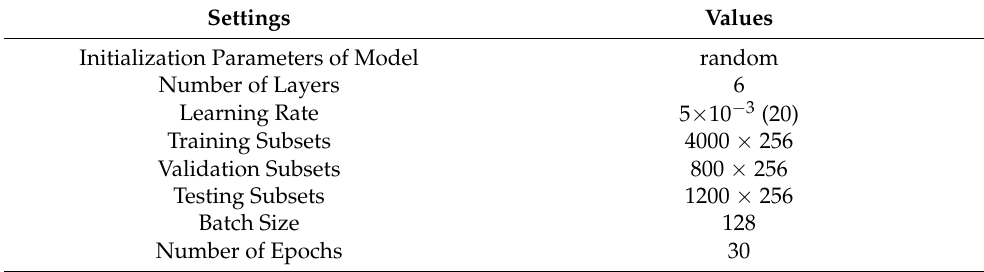
Table 3. The training hyperparameters.